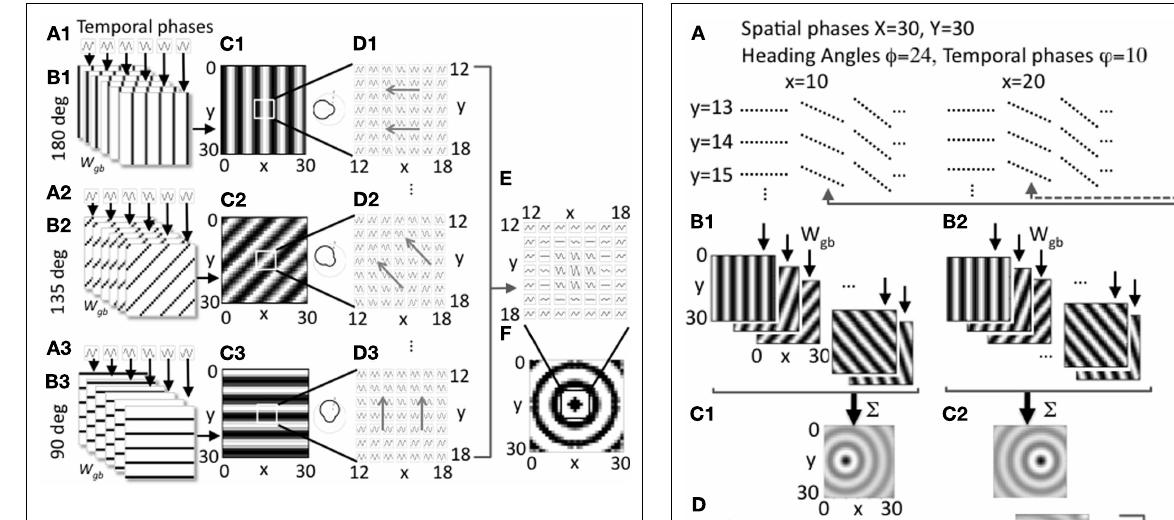
1 is shown for different temporal phases in Figures 1A1–A3 .